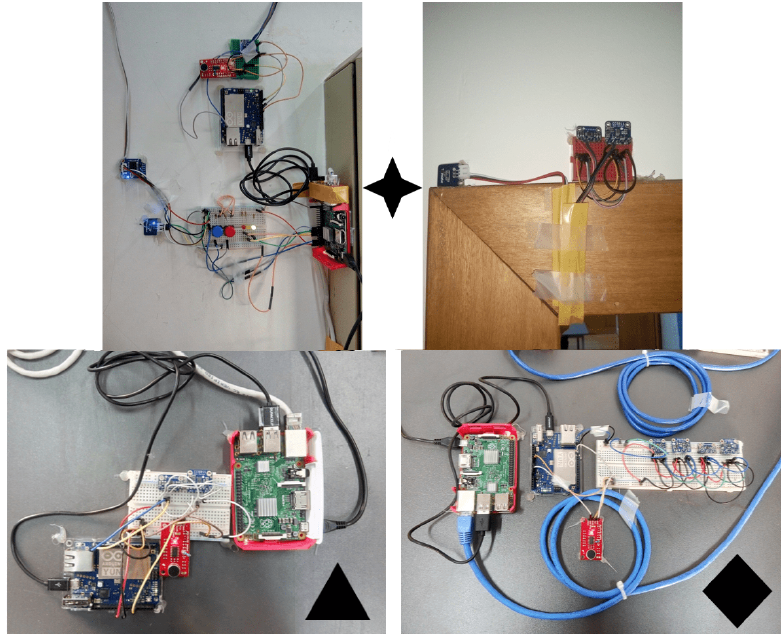
Figure 3. Nodes and sensors deployed in the testbed: ( top ) Node 1 (( left ) indoor sensors; and ( right ) outdoor temperature sensor); and ( bottom ) Node 2 (( left ) and Node 3 ( right